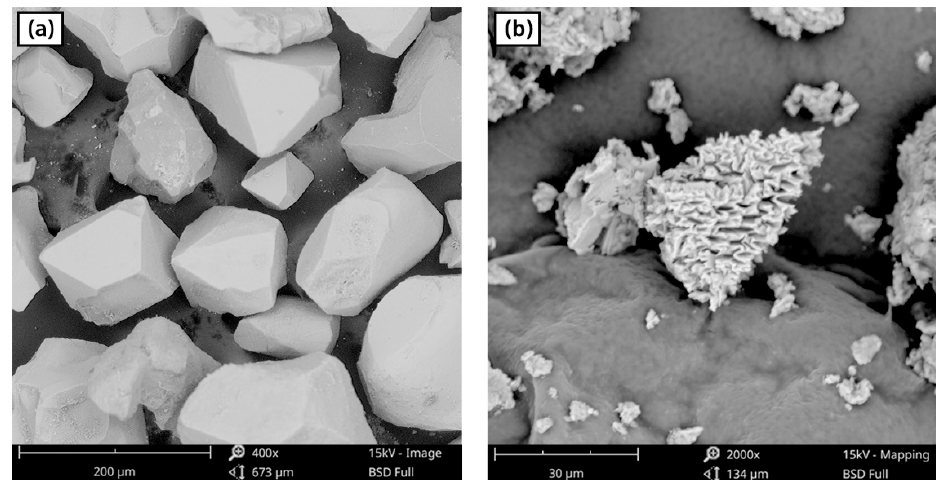
Figure 4. Scanning electron microscopy (SEM) images of low Fe(II)-chromite (LFC) ( a ) before and ( b ) after leaching at 176 °C with a sulfuric acid concentration of 81% and dichromic acid/chromite ratio of 0.12.